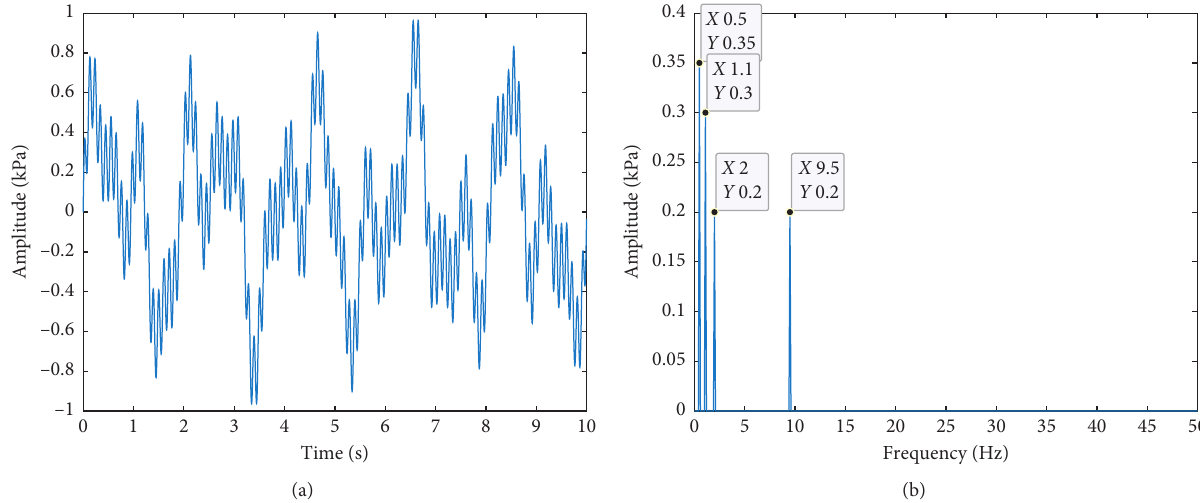
Figure 2: Simulation without noise waveform and spectrum diagram. (a) Waveform diagram. (b) Spectrogram.